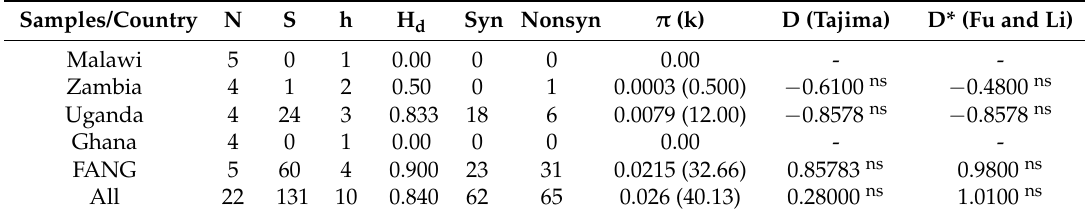
Table 1. Summary statistics for polymorphism of CYP6AA1 haplotypes across Africa.